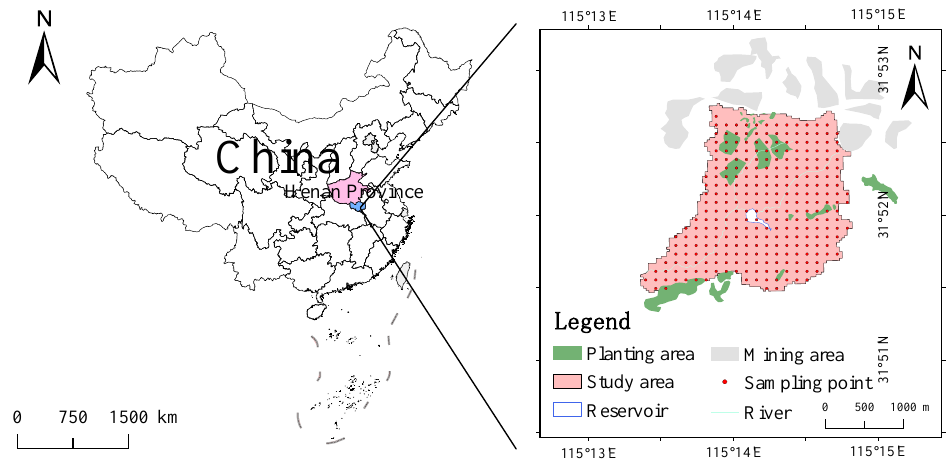
Figure 1. Overview of the study area and distribution of sampling sites.